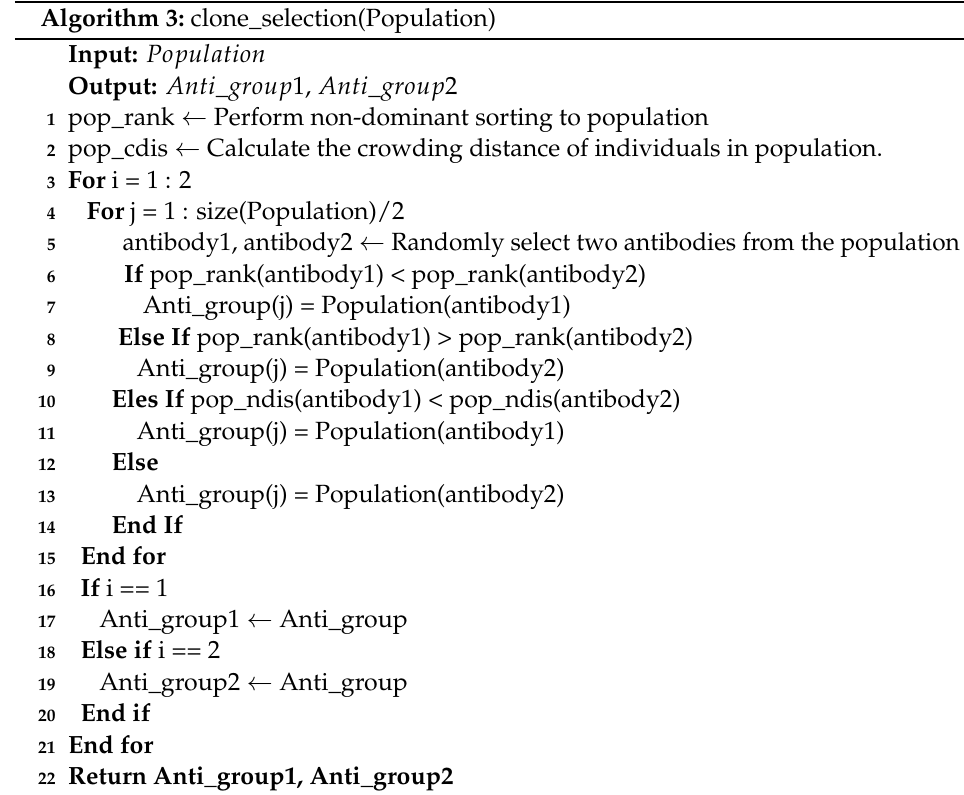
Figure 4. Generation process of antibody Group 1 and antibody Group 2. Algorithm 3: